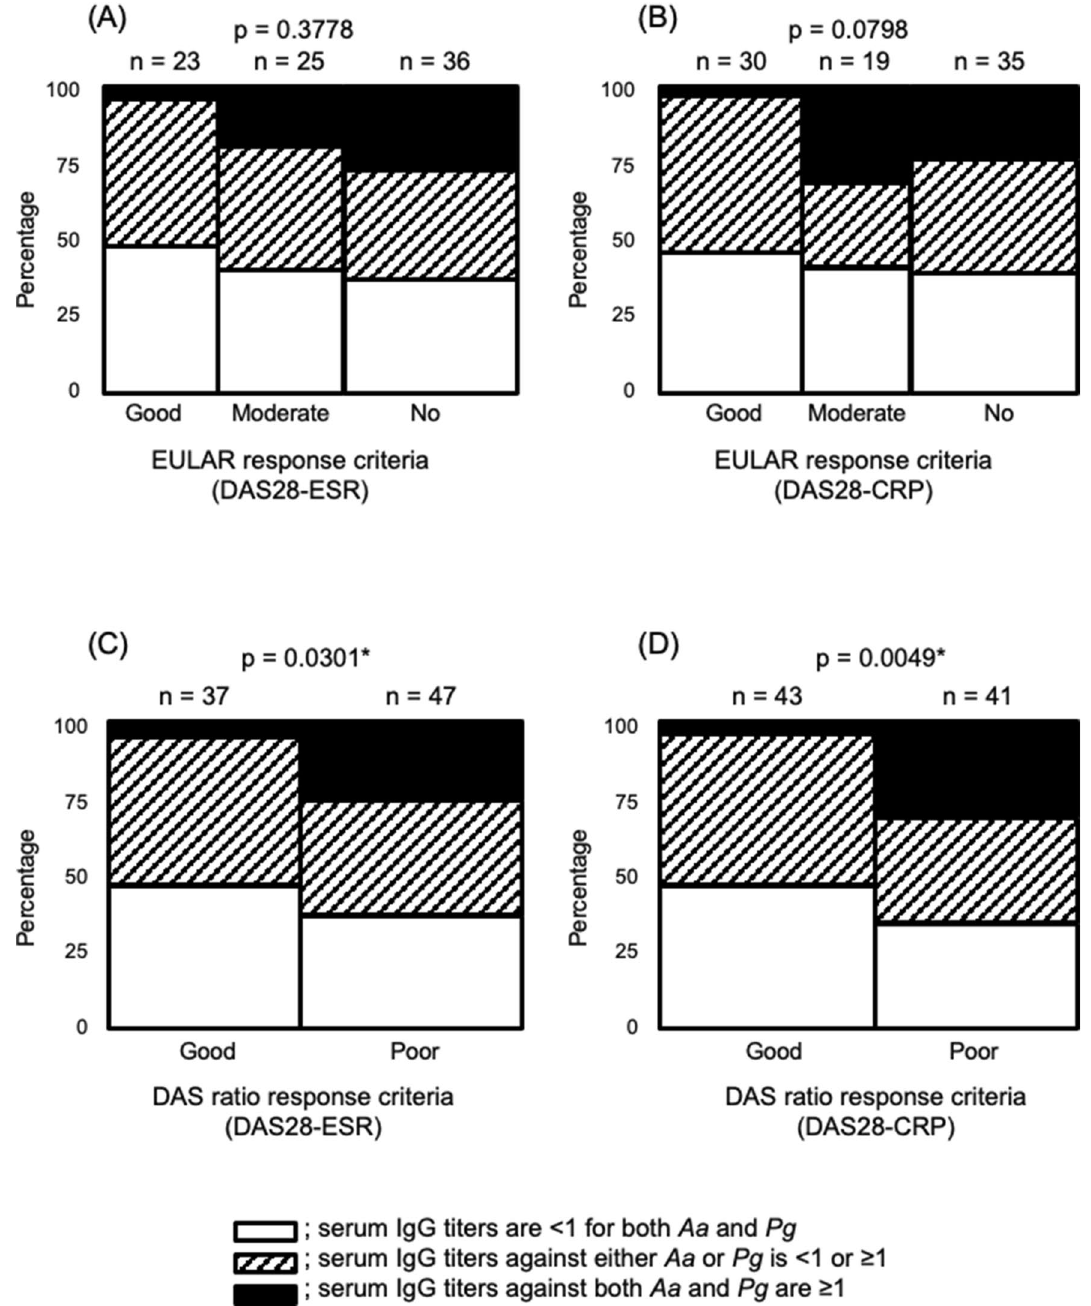
ESR; ( B , D ): DAS28-CRP. Open bar: serum IgG titers are < 1 for both Aa and Pg ; shaded bar: serum IgG titers against either Aa or Pg is < 1 or ≥ 1; closed bar: serum IgG titers against both Aa and Pg are ≥ 1. Poor responders had high IgG titers against Aa and Pg . (P-value: Pearson’s chi-square test, * < 0.05). Aa Aggregatibacter actinomycetemcomitans , CRP C-reactive protein, DAS disease activity score, ESR erythrocyte sedimentation rate, EULAR European Alliance of Associations for Rheumatology, IgG immunoglobulin G, Pg Porphyromonas